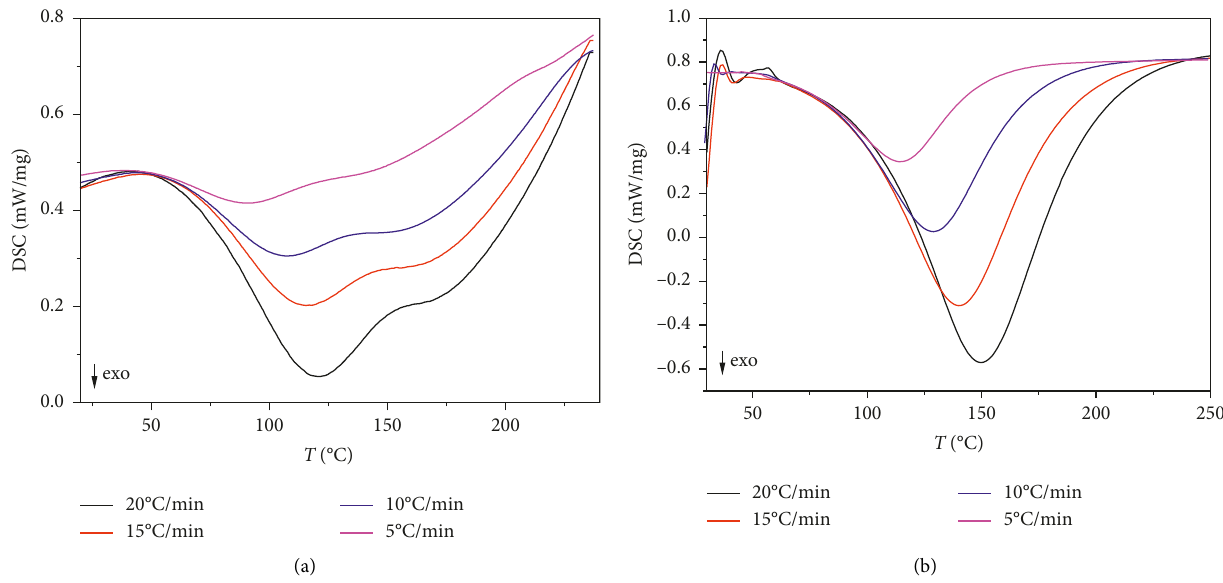
Figure 4: DSC curves of (a) CME and (b) HME with different heating rates.